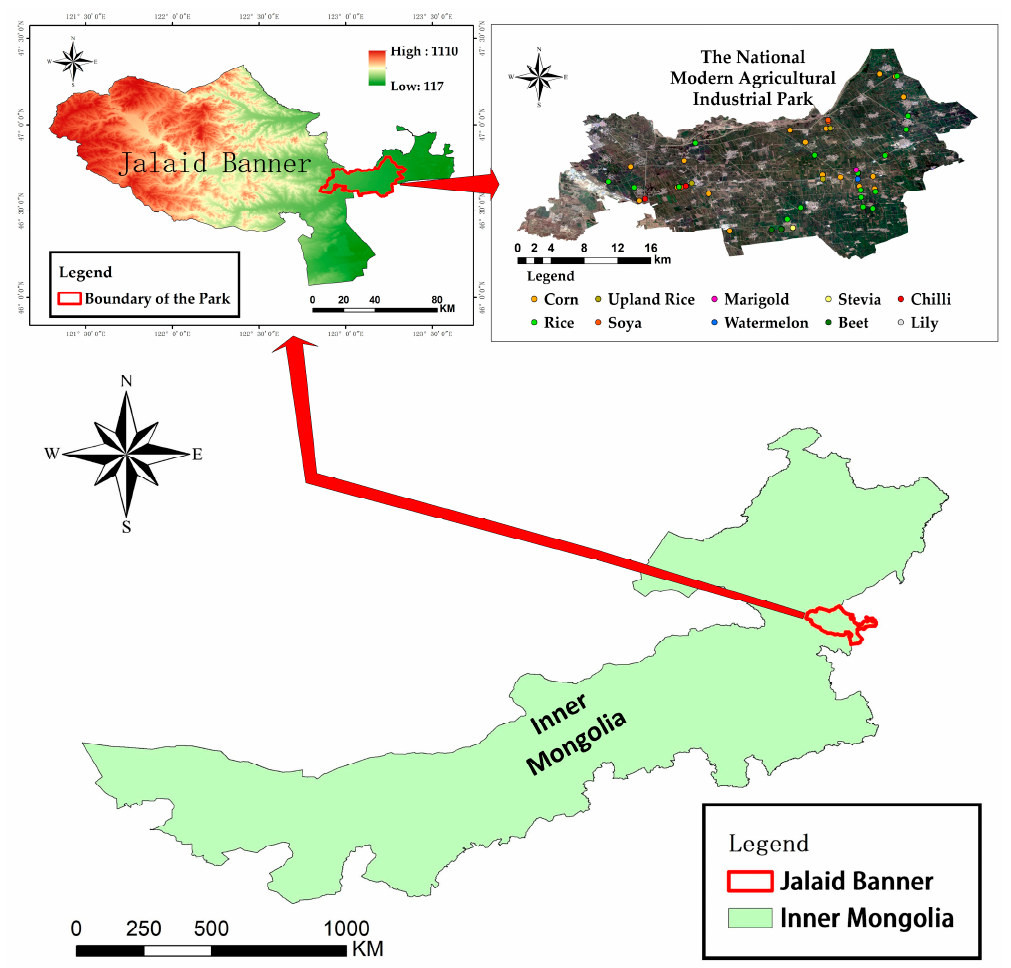
Figure 1. Topographic map of the Modern Agricultural Industrial Park in Jalaid Banner. The geographical location and topographic information of Jalaid Banner are displayed, as well as the location of the park and the distribution of the sample points.